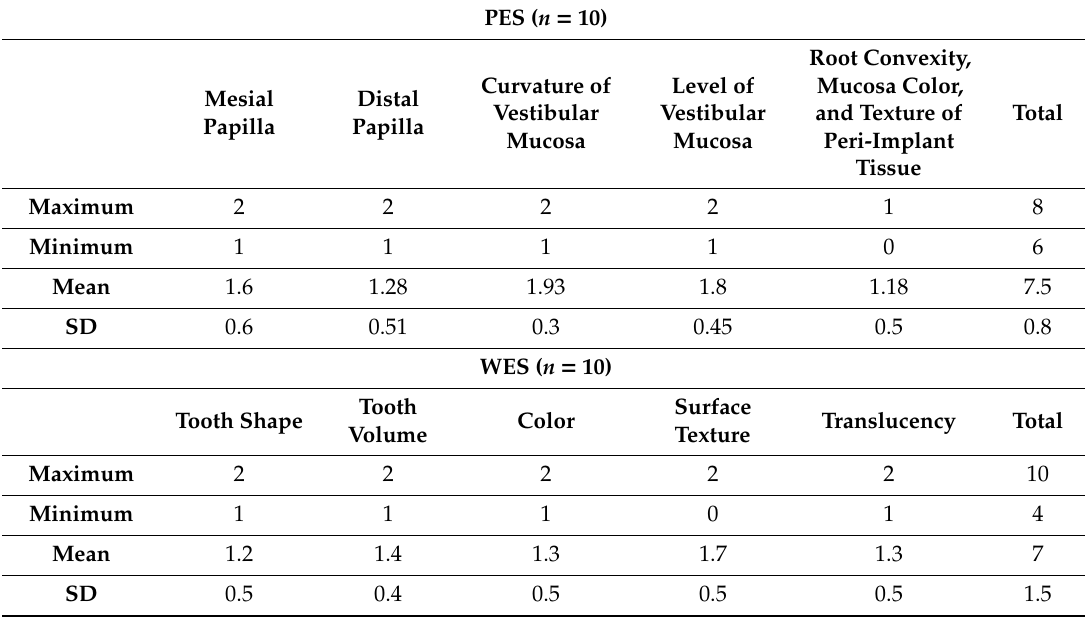
Table 5. Pink and white aesthetic scores (PES / WES) at the end of the follow-up (2 to 9 years). PES ( n =